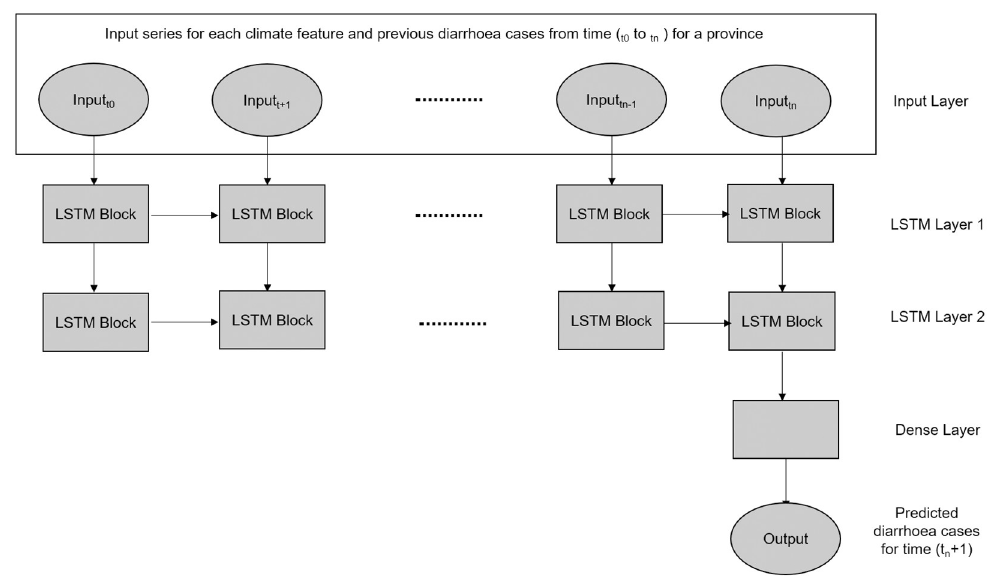
Fig 3. Basic structure of the Long-term Short Term (LSTM) method with two LSTM layers.